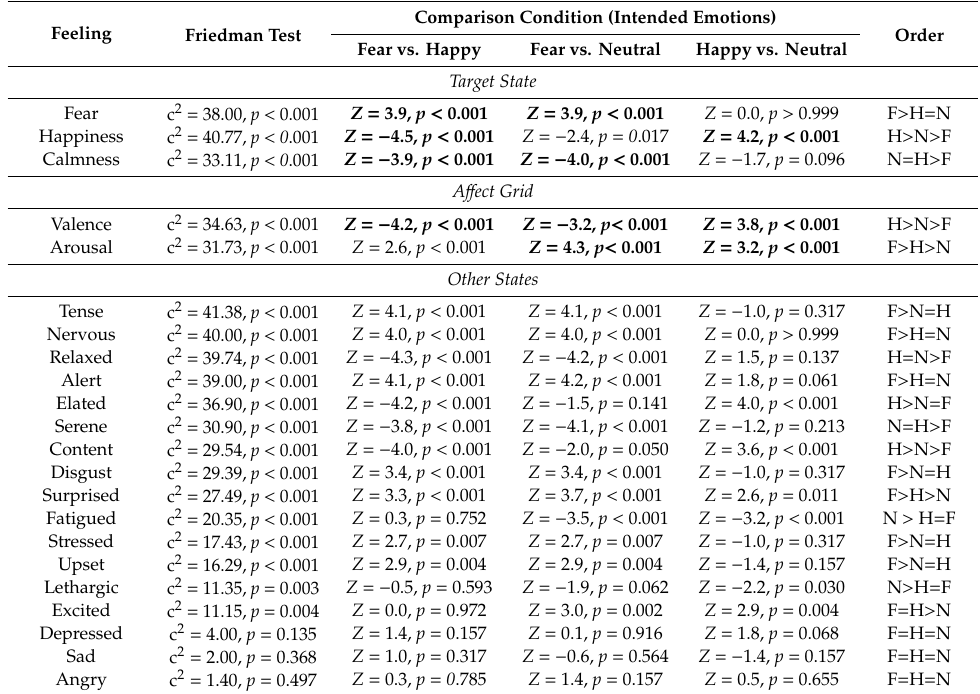
Table 1. Results of emotion manipulation on 20 discrete emotion states, three of which are the target states, rated from 0 to 5, and separately on valence, and arousal (a ff ect grid). Order Fear vs. Happy Fear vs. Neutral Happy vs.